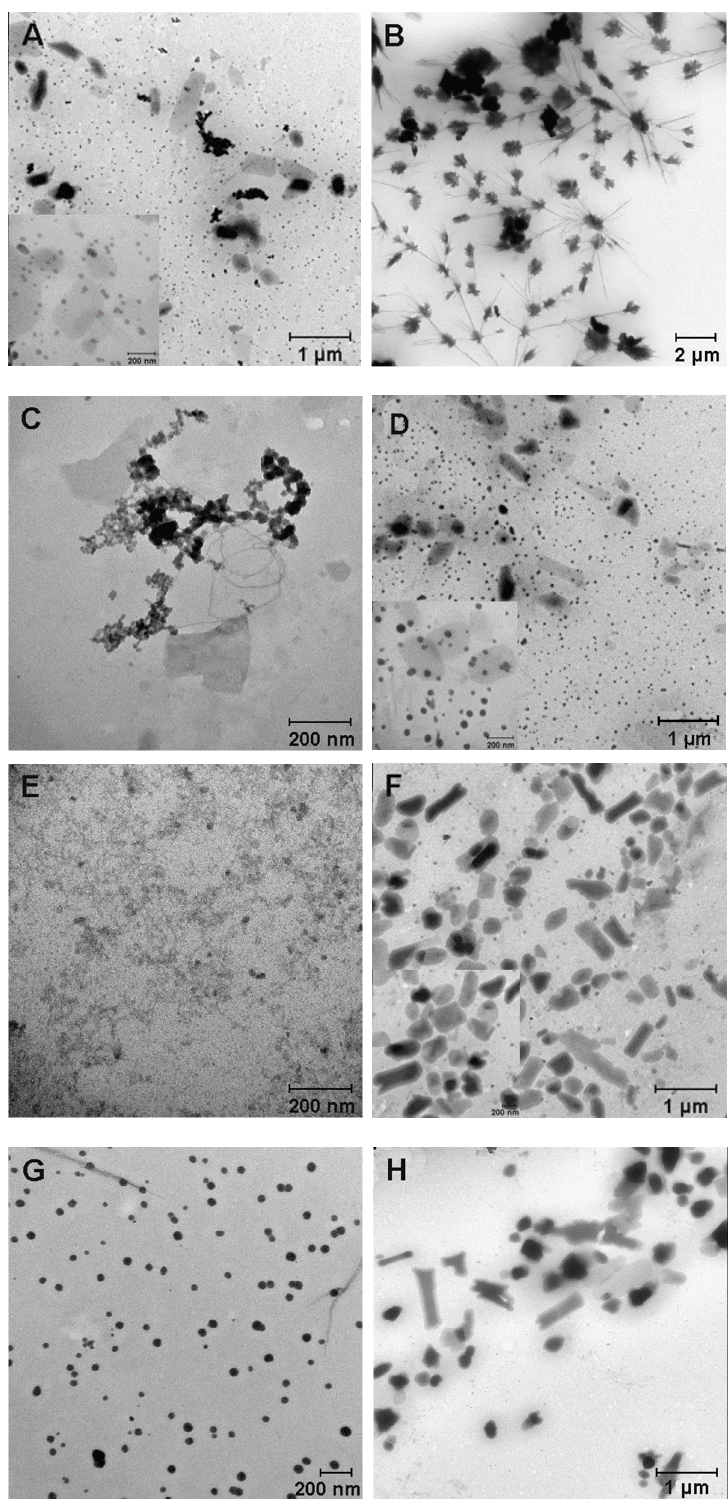
volume did not increase the hydrodynamic size of the CaNPs.